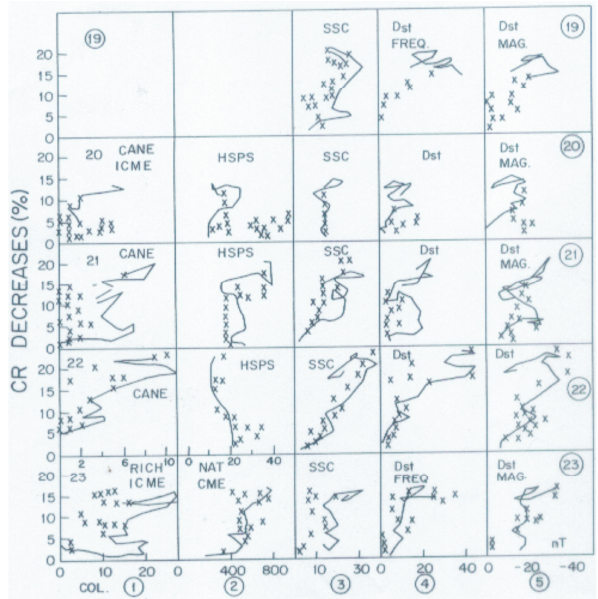
Fig. 7. Hysteresis plots of Cosmic Ray (CR) intensity (ordinate in percent, 3-monthly values) versus CMEs, ICMEs, HSPS, SSC count and D st occurrence frequencies and magnitudes. The full lines are for the rising part of the solar cycle and the crosses for the declining